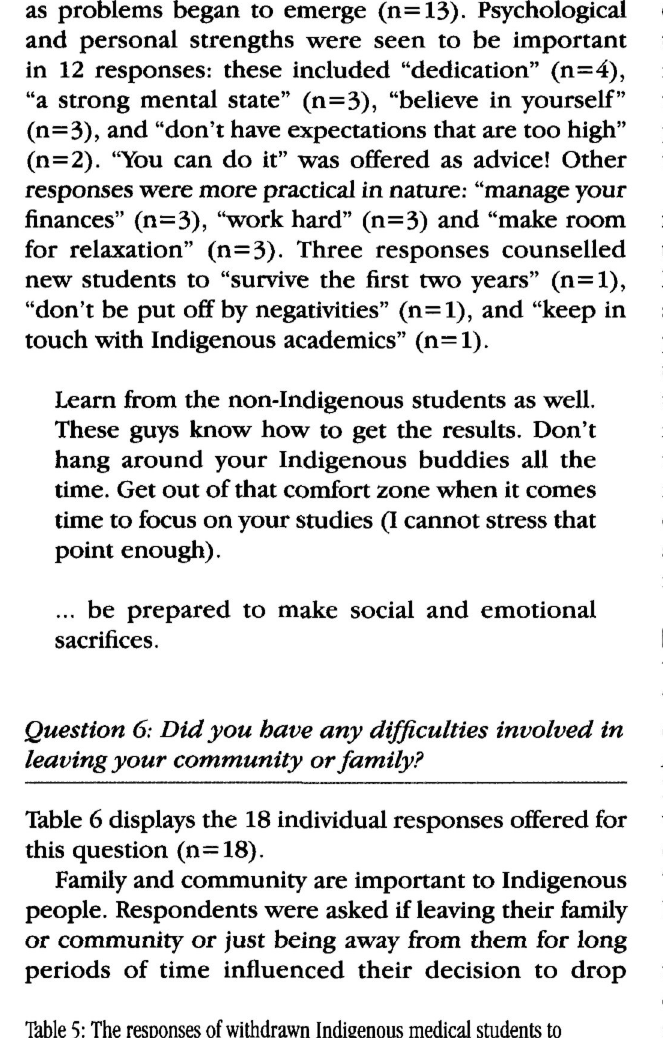
Table 5: The responses of withdrawn Indigenous medical students to Question 5: What advice would you give new students?